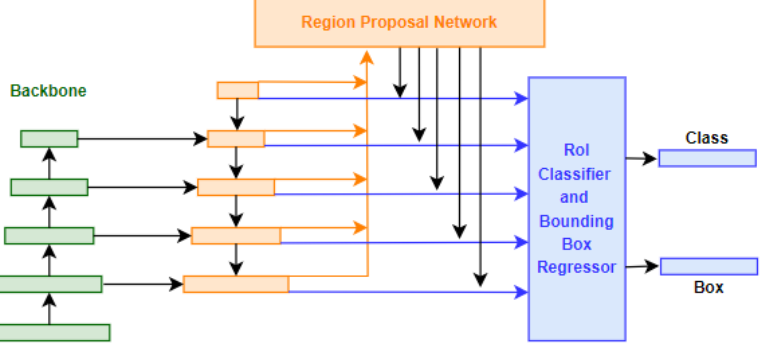
Figure 3. Faster R-CNN general architecture (adapted from [24]).